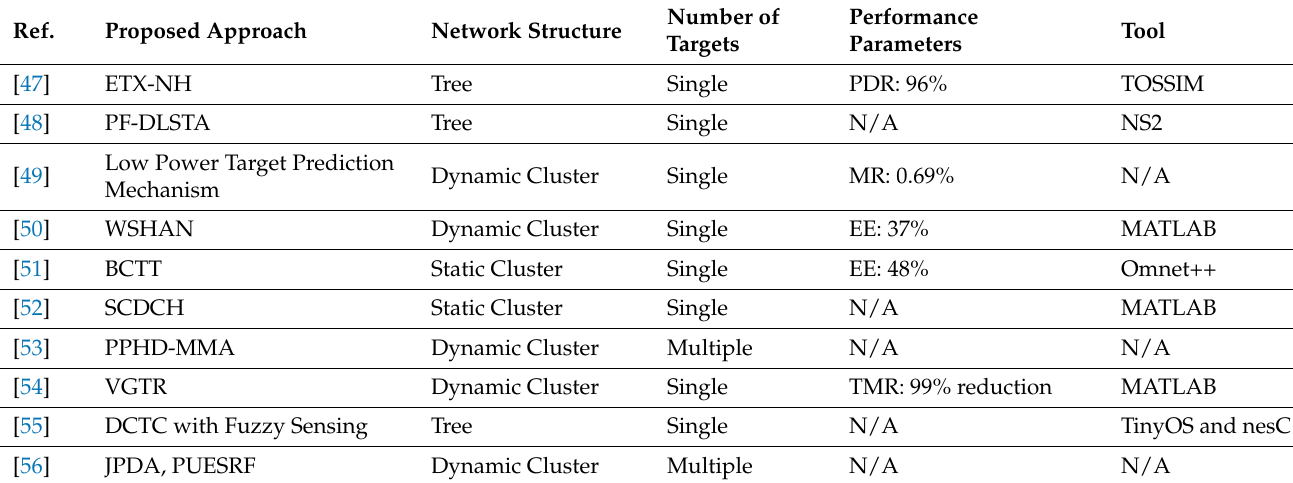
Table 6. Overview of selected